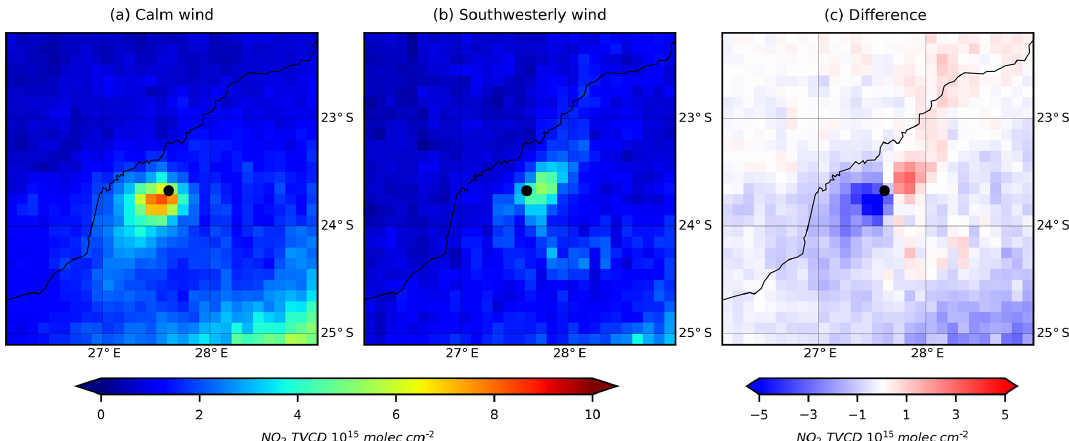
Figure 10. Mean OMI NO 2 tropospheric VCDs around the Matimba power plant (Lephalale, South Africa) for (a) calm, (b) southwesterly wind conditions, and (c) their difference (southwesterly minus calm) for the period of 2005–2017. The location of Matimba is represented by a black